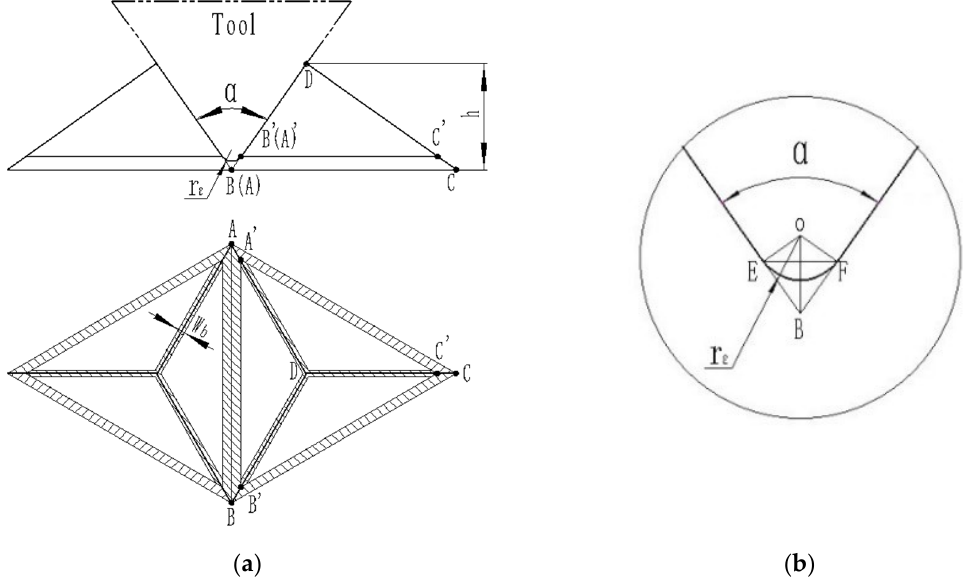
Figure 3. Invalid retro-reflection region: ( a ) Schematic diagram of the invalid retro-reflection area, ( b ) invalid area of the valley